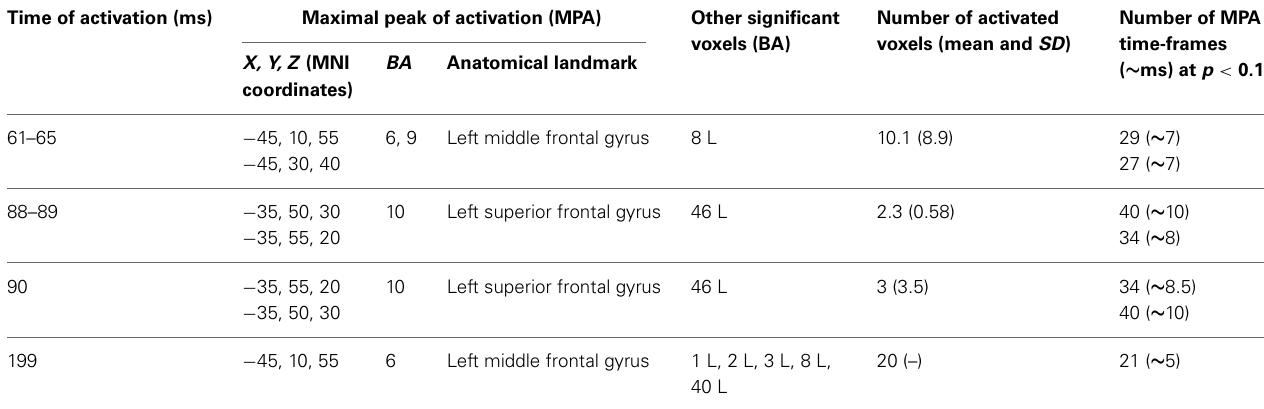
Table 2 | Results from time-frame by time-frame sLORETA analysis (log of F-ratio). Time of activation